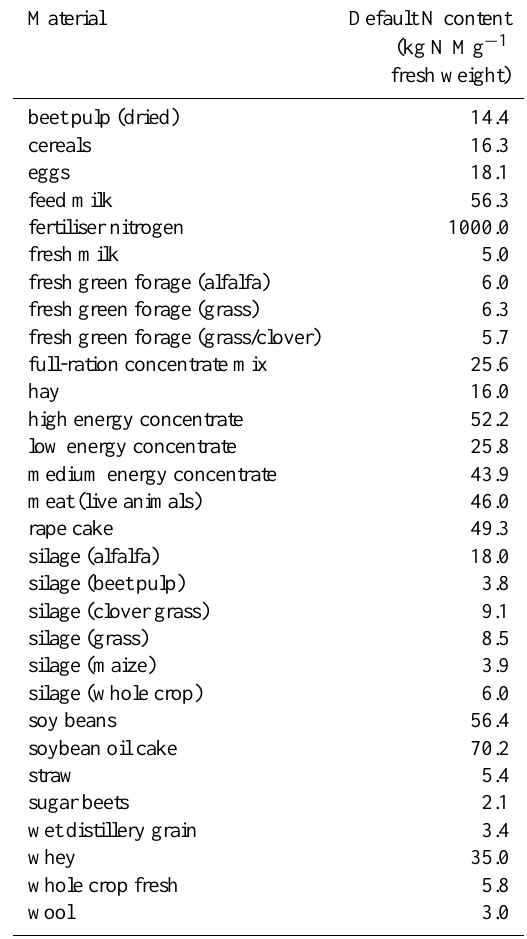
Table 1. Default N contents of imported and exported